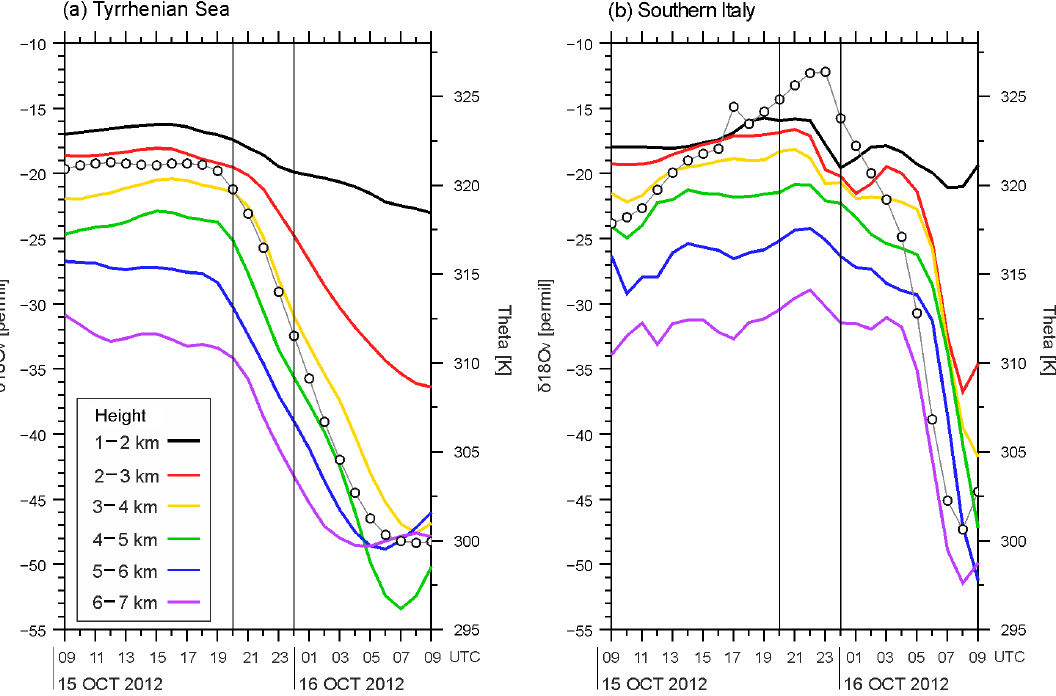
Figure 5. The averaged values of potential temperature ( θ , K) at 850hPa (thin line with dot) and δ 18 O v (‰) at altitudes of 1–2kma.s.l. (black), 2–3kma.s.l. (red), 3 − 4kma.s.l. (yellow), 4 − 5kma.s.l. (green), 5 − 6kma.s.l. (blue), and 6–7kma.s.l. (purple) over the sea surface upstream of the HPE of IOP 13 within domains of (a) the Tyrrhenian Sea (marked by “TY” in Figs. 1, 3, and 4) and (b) southern Italy (marked by “SI”) from 09:00UTC on 15 October 2012 to 09:00UTC on 16 October 2012.